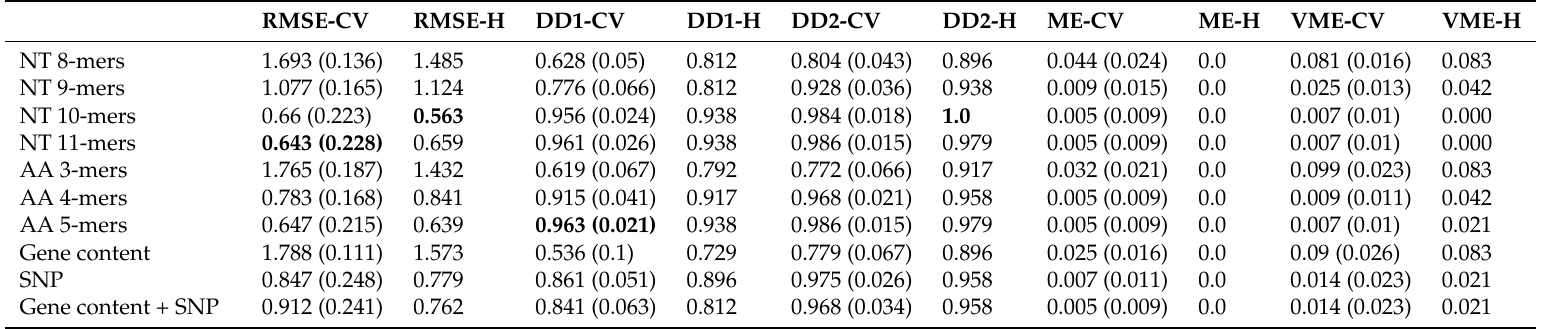
Table A18. C. jejuni –nalidixic